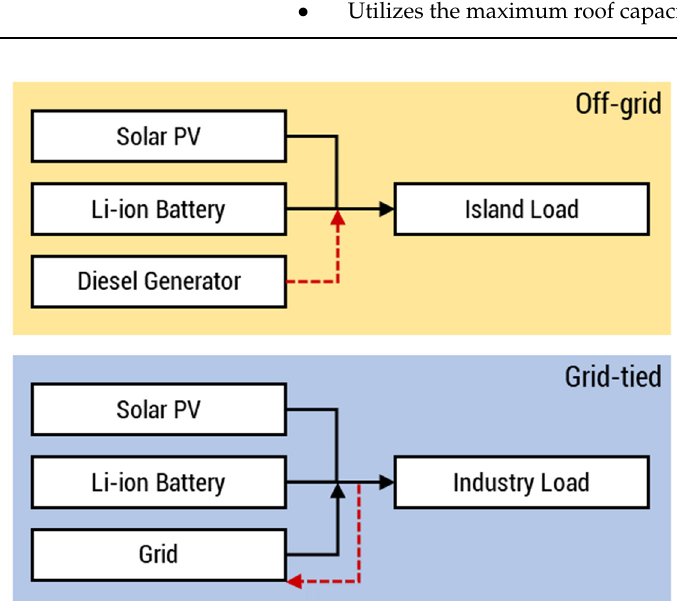
ff -grid ( top ) and grid-tied ( bottom ) energy Figure 2. Architecture of the hybrid off-grid ( top ) and grid-tied ( bottom ) energy systems. Figure 2. Architecture of the hybrid o